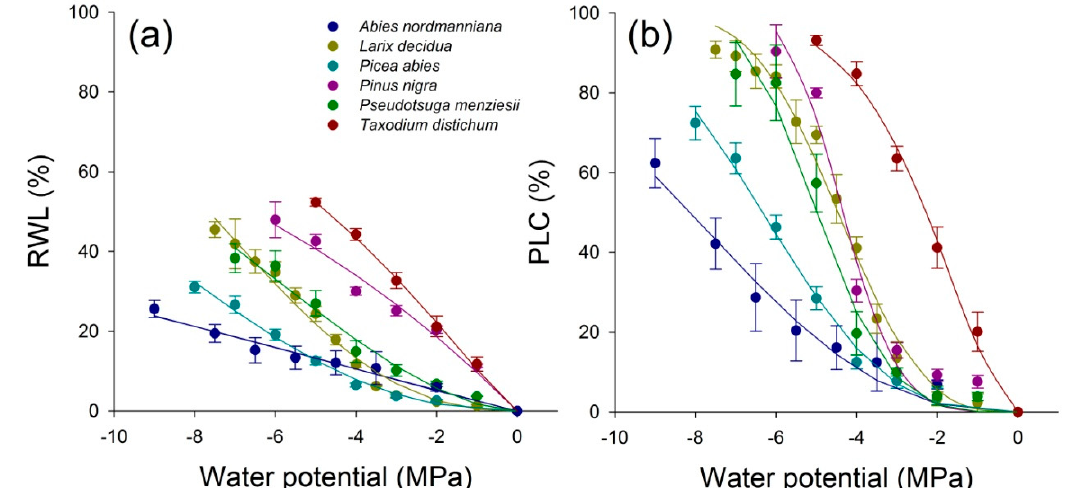
Figure 2. Empirical hydraulic traits; ( a ) relative water loss (RWL) and ( b ) percent loss of hydraulic conductivity (PLC) plotted against the negative of the air pressure applied in a pressure collar (water potential) for six different conifer species. Error bars indicate one standard error. Curves for mean values were fitted by a Weibull equation [38].